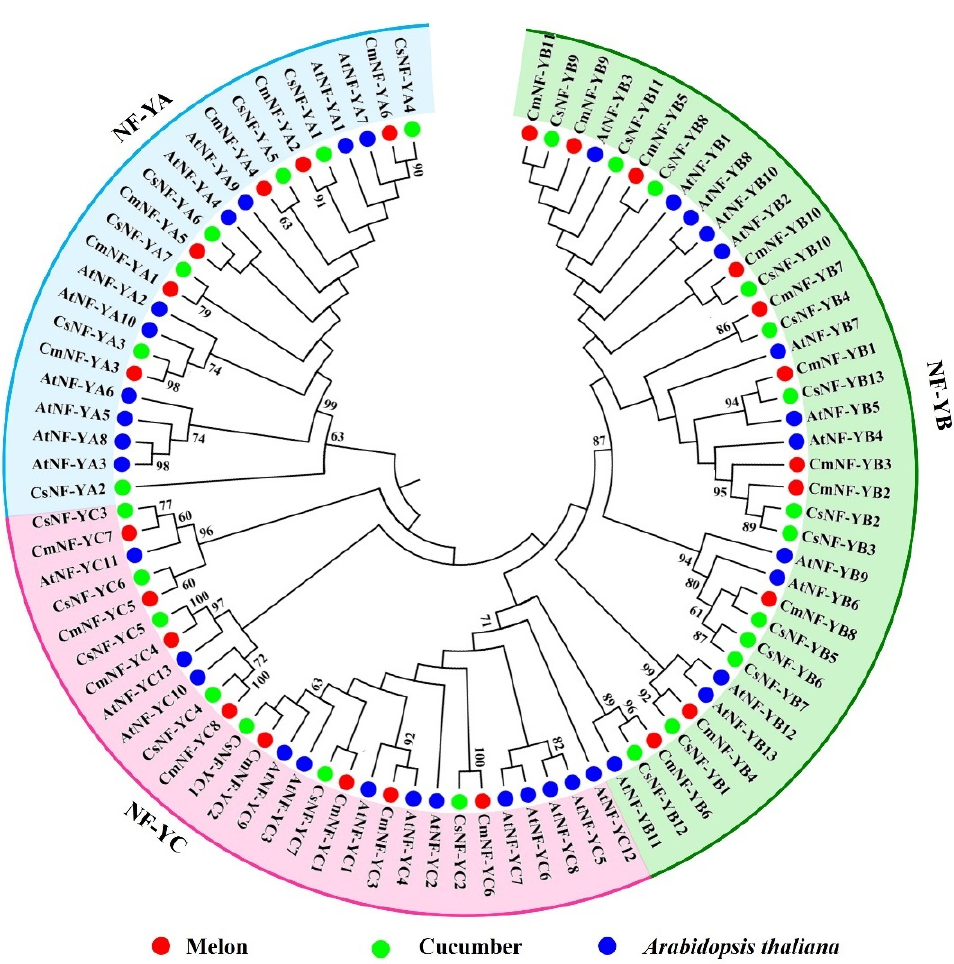
Figure 5. Molecular phylogenetic analysis of 88 NF-Y proteins from melon ( Cucumis melo L.), cucum- ber ( Cucumis sativus ), and Arabidopsis thaliana . MEGA 11 was used to build the maximum likelihood (ML) tree with 1000 bootstrap replicates.